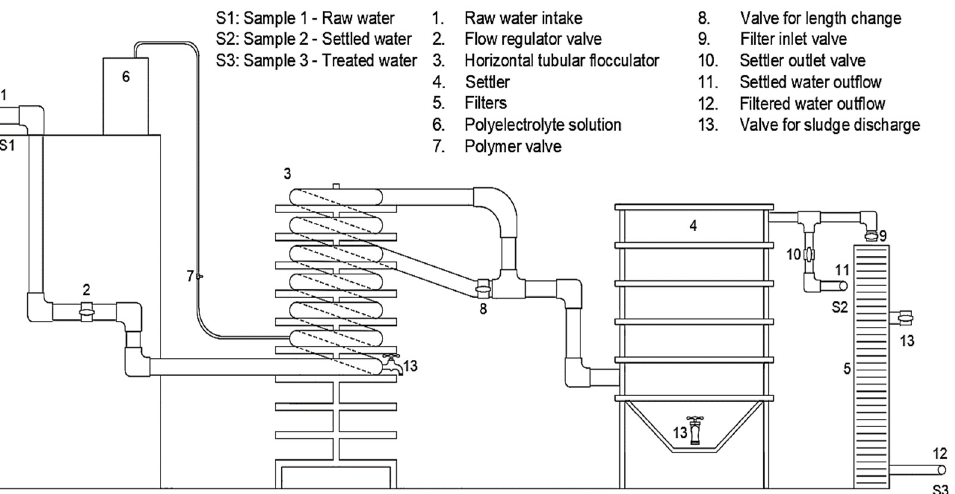
Figure 3. Location of sampling points: (a) S1 Raw water, (b) S2 settled water, and (c) S3 filtered water.